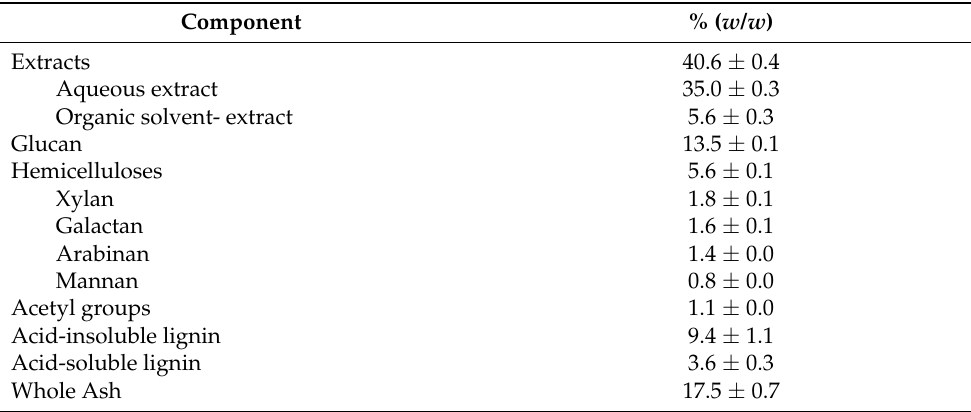
Table 1. VTPW from greenhouse crop composition. Data expressed as percentage ( w/w ) on a dry weight (DW) basis.